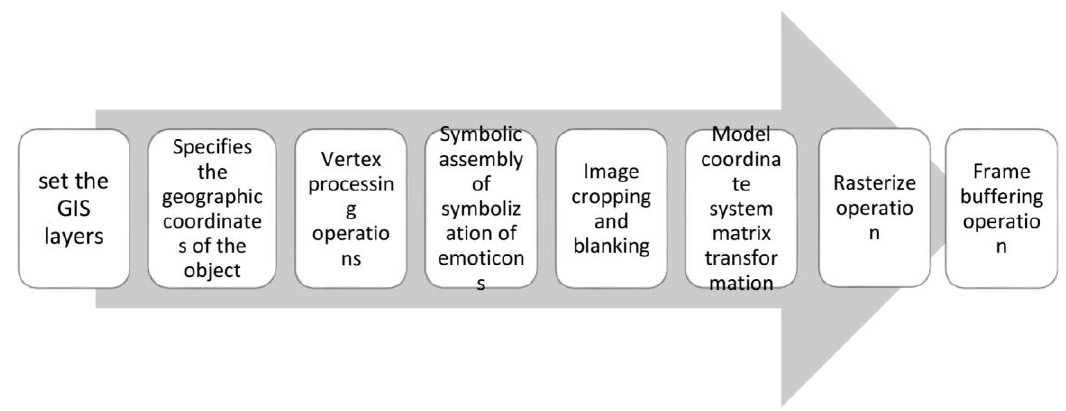
Figure 7. The principle of AUGL engine map symbol pre-caching.